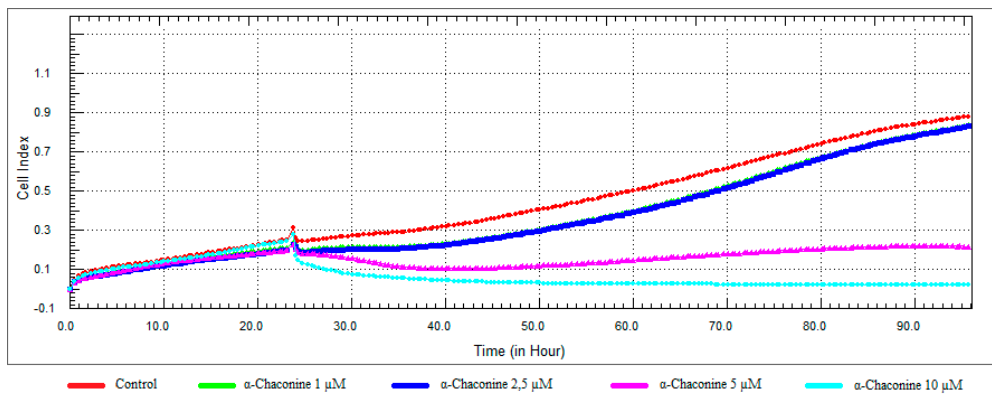
Figure 7. Dose and time-dependent cytotoxic effect and alteration of CI of α -chaconine determined by xCELLigence system: Effect of α -chaconine on proliferation of RL95-2 cell. Cells were treated with various concentrations of α -chaconine for 72 h. The CI was calculated from four repeated measurements.